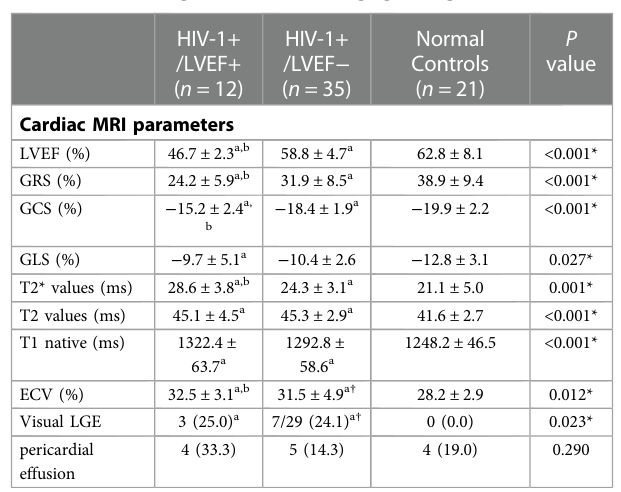
TABLE 1 Cardiac magnetic resonance imaging fi